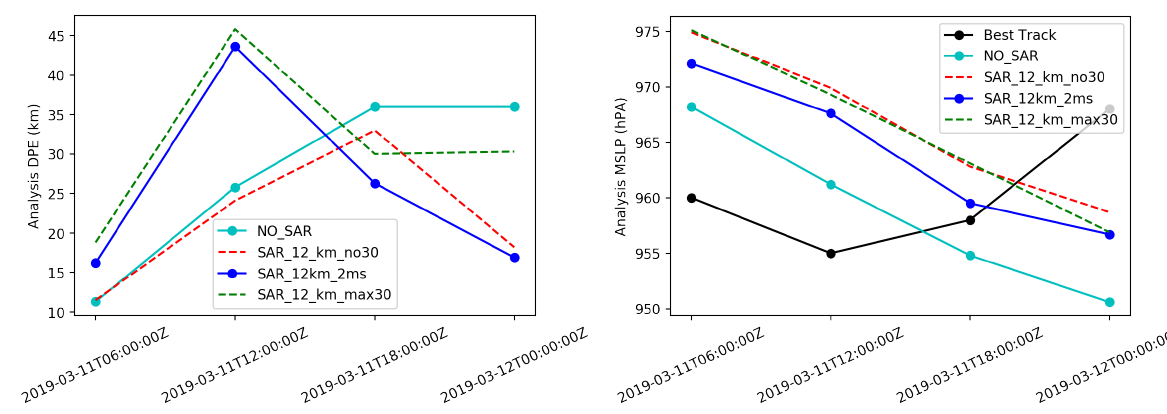
Figure 23. Evolution of DPE ( left ) and MSLP ( right ) in analyses of 11 March 2019 06:00, 12:00, 18:00Z and 12 March 2019 00:00Z for NO_SAR, SAR_12km_2ms, SAR_12km_max30,